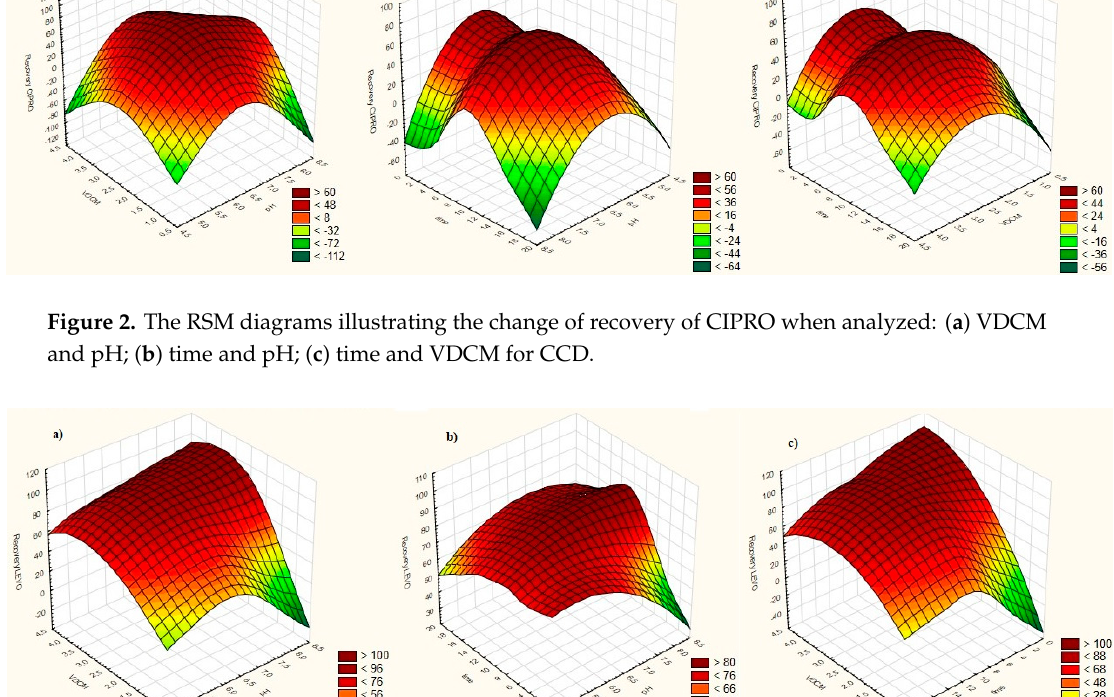
Figure 3. The RSM diagrams illustrating the change of recovery of LEVO when analyzed: ( a ) VDCM and pH; ( b ) time and pH; ( c ) time and VDCM for CCD.